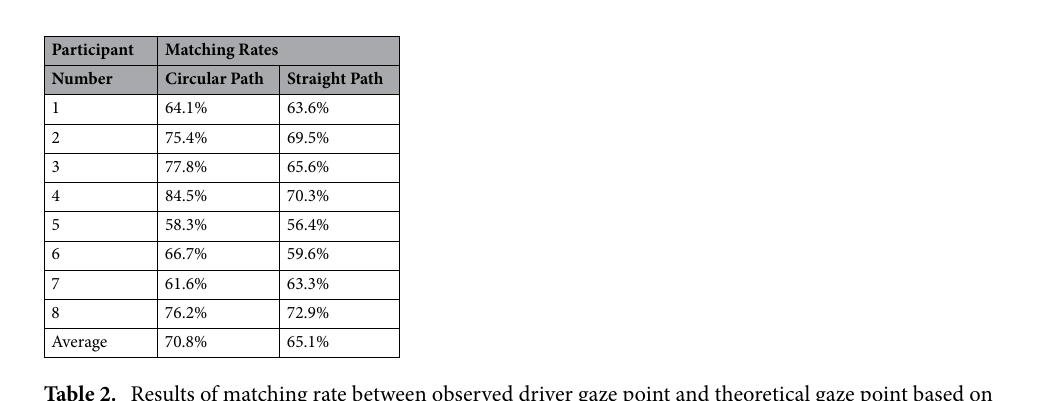
Table 2. Results of matching rate between observed driver gaze point and theoretical gaze point based on optical flow theory for each